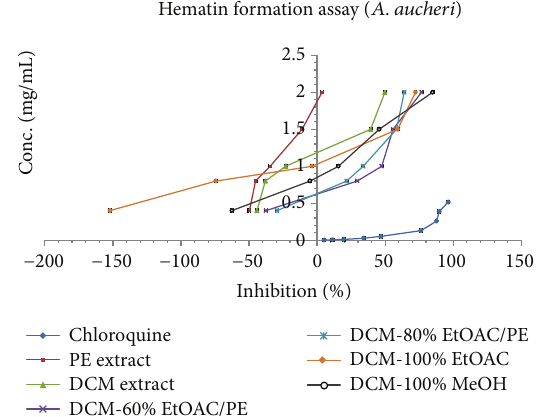
Figure 3: Comparison of %inhibition of heme crystallization between active extracts and fractions of A. aucheri and chloroquine solution in 𝛽 -hematin formation assay. The values were reported as Mean ±